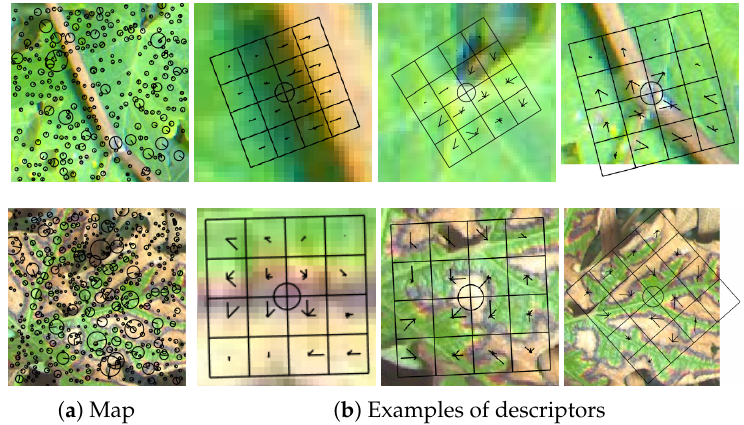
Figure 6. (First row) ( a ) Keypoints map and ( b ) three examples of keypoints descriptors on a 4 × 4 grid on healthy leaf (extracted on hue channel); and (Second row) keypoints map and three examples of descriptors on esca